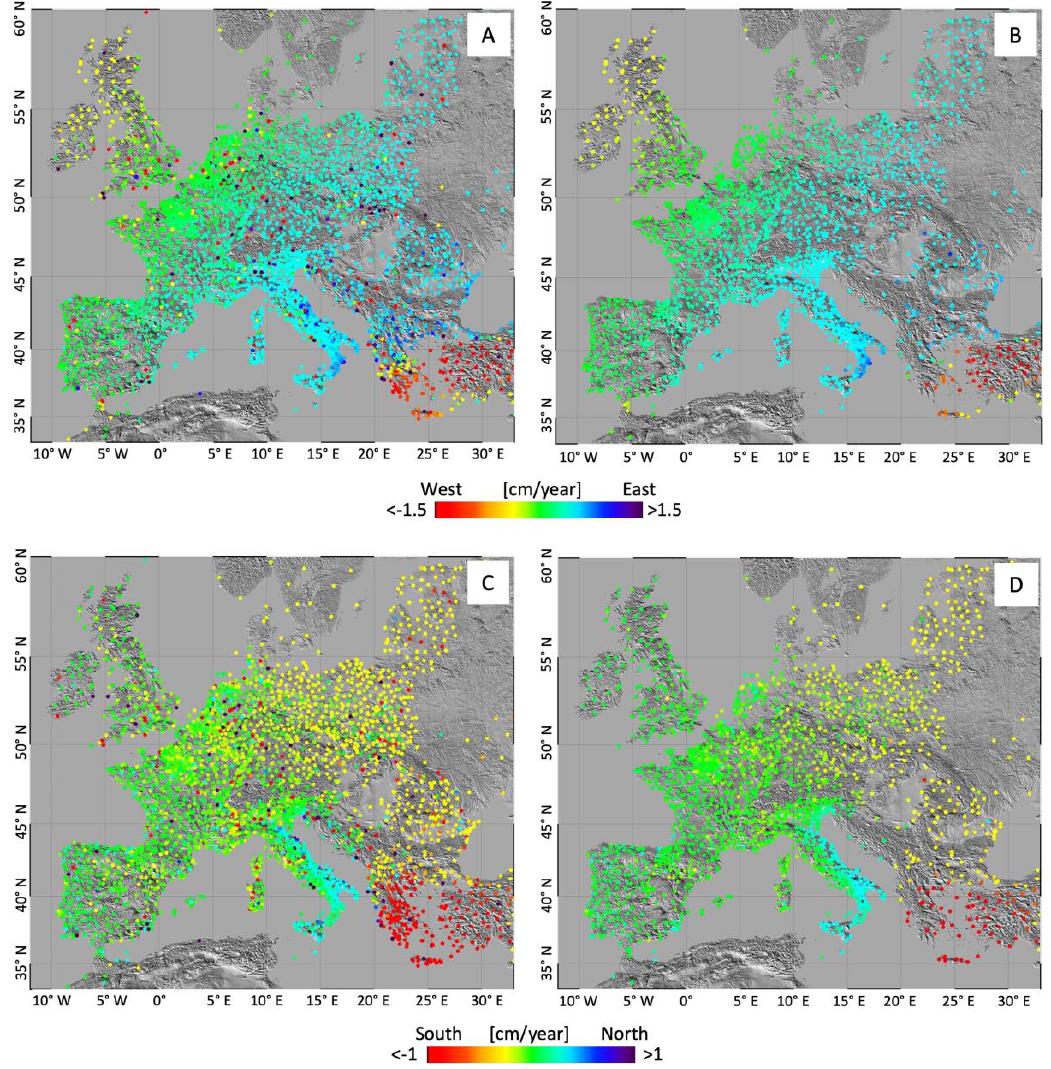
Figure 5. Planar components of the GNSS stations identified through our data screening and selection procedure, superimposed on the 1-arcsec STRM DEM of the investigated area. ( A , B ) The East/West velocity components before ( A ) and after ( B ) the implemented procedure. ( C , D ) The same as ( A , B ) but for the North/South velocity components.